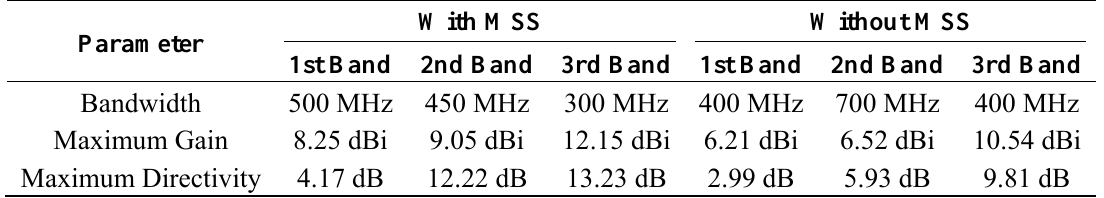
Table 1. Performance specifications of the proposed antenna with and without